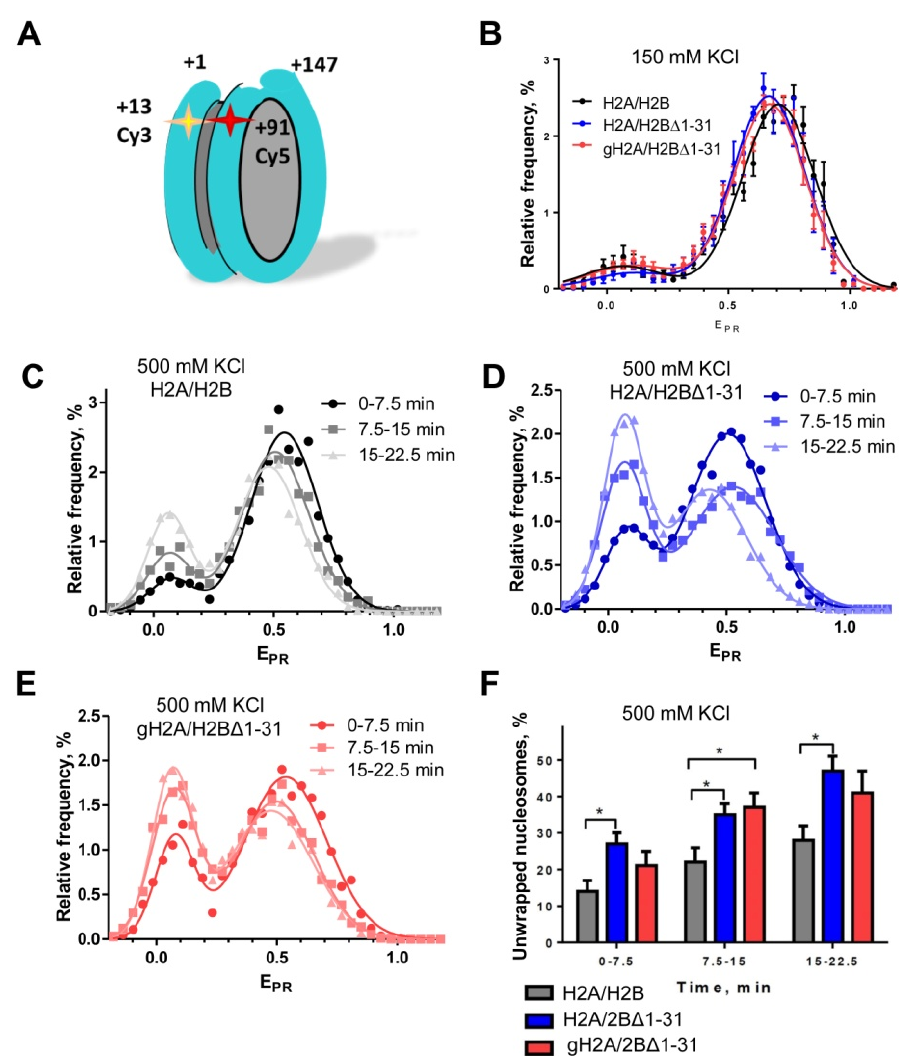
Figure 3. Histone H2B N-tail stabilizes the nucleosome structure. Nucleosomes containing H2A/H2B, H2A/H2B Δ 1-31 or gH2A/H2B Δ 1-31 histones were studied by spFRET microscopy at 150 mM KCl ( A ) or 500 mM KCl ( B – E ). ( A ) A schematic diagram of the nucleosome labeled with Cy3 and Cy5 dyes (asterisks). ( B ) Frequency distributions of nucleosomes by E PR at 150 mM KCl. ( C – E ) Typical frequency distributions of nucleosomes by E PR at 500 mM KCl as a function of time: NCP with H2A/H2B ( C ), NCP with H2A/H2B Δ 1-31 ( D ) and NCP with gH2A/H2B Δ 1-31 ( E ). ( F ) Relative content of nucleosomes with uncoiled DNA (low-E PR subpopulation) at 500 mM KCl as a function of time (mean ± SEM, n = 3–5, * p < 0.05). Note that both H2A/H2B Δ 1-31 and gH2A/H2B Δ 1-31 nucleosomes contain more uncoiled DNA than the H2A/H2B nucleosomes. To evaluate the effect of H2B Δ 1-31 and gH2A/H2B Δ 1-31 deletions on nucleosome